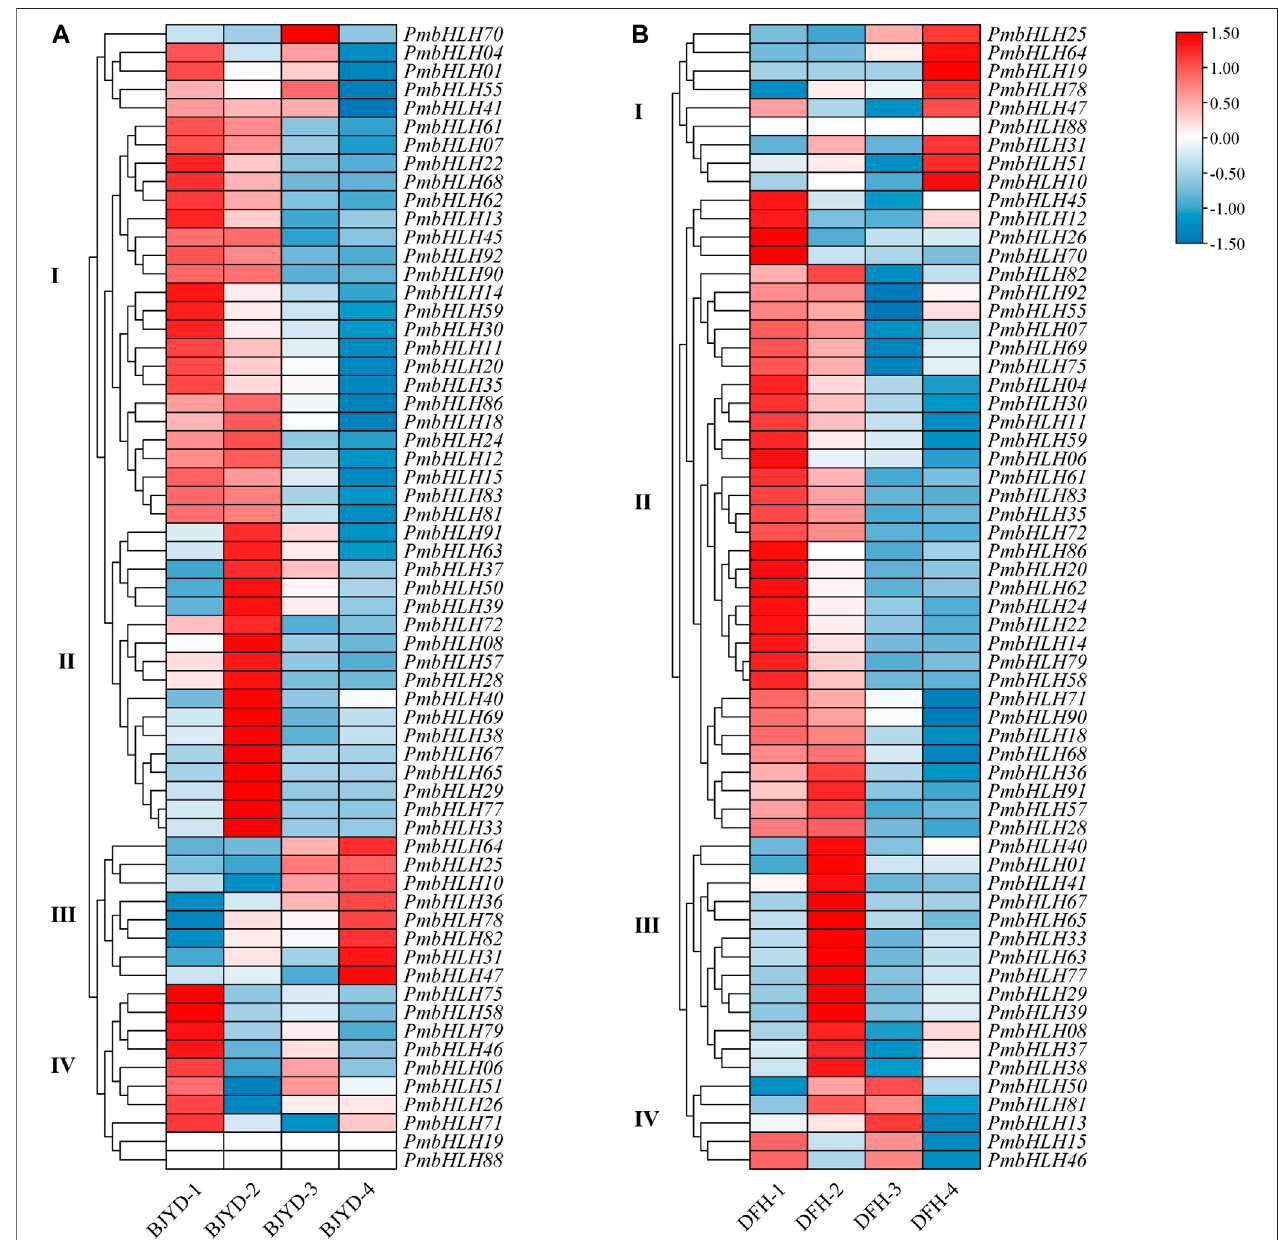
FIGURE 5 | Hierarchical clustering of the expression pro fi le of PmbHLHs in ‘ Beijing Yudie ’ (A) and ‘ Danfenghou ’ (B) under low-temperature treatment. “ 1 ” represents stems that were treated at 25 ° C, “ 2 ” represents stems that were treated at 4 ° C for 8 h, “ 3 ” represents stems that were treated at 4 ° C for 5 days, “ 4 ” representsstemsthatweretreatedat − 5 ° Cfor1 h.HeatmapsweregeneratedwithFPKMvalues.Colorfulscalemeansrelativeexpressionlevelandisshownatthetop. Red represents high expression and blue represents low expression. Hierarchical clustering groups are displayed by roman